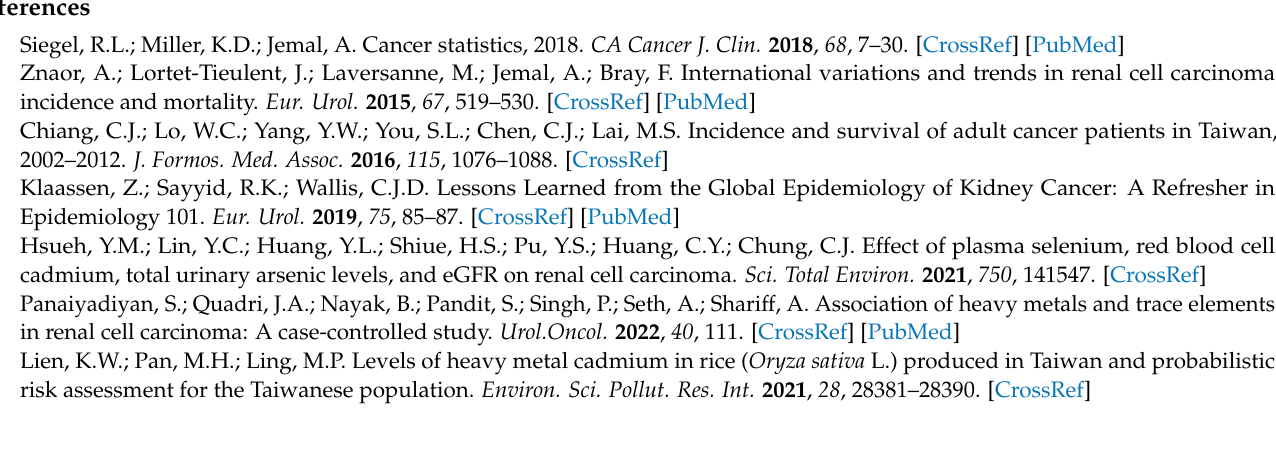
Table S2: Comparison of 5mdc (%) and blood cadmium concentrations between RCC cases and controls stratified by a combination of plasma folate and vitamin B 12